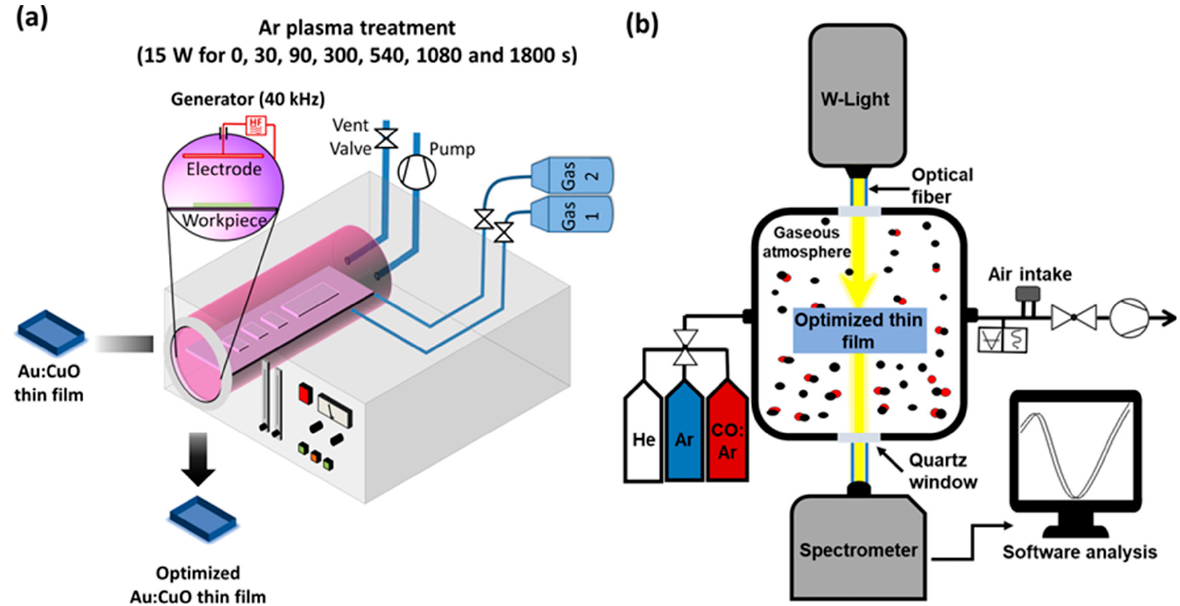
Figure 1. Simplified representation of the ( a ) Plasma Cleaner equipment used for Au:CuO film’s surface modification with different Ar plasma treatment times, and ( b ) custom-made high-resolution LSPR spectroscopy system for gas sensing test measurements in a controlled atmosphere.